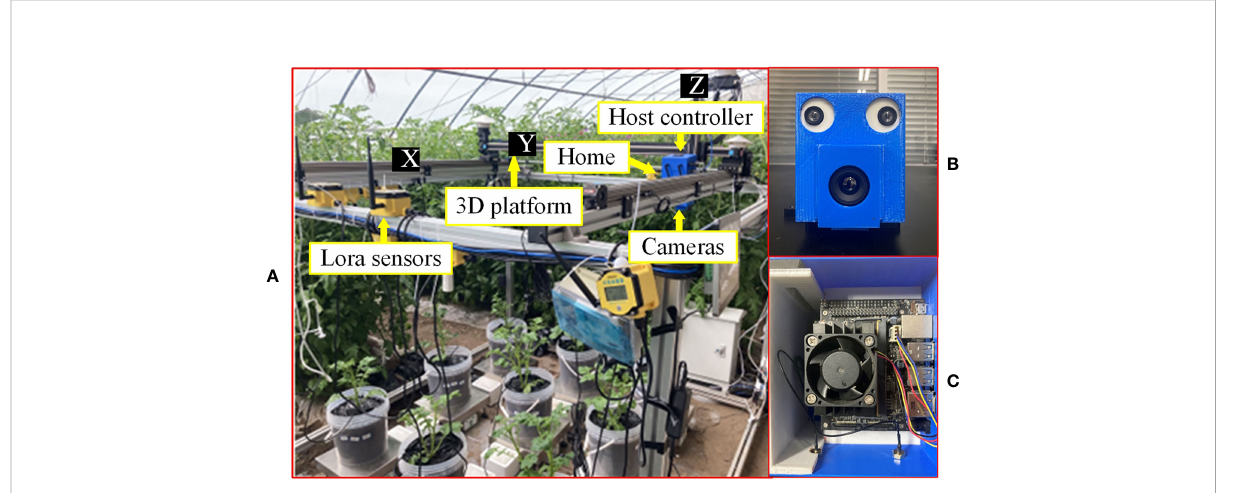
FIGURE 1 Equipment and apparatus used for experiments in this study: (A) overall experimental platform, (B) image acquisition module, and (C) host